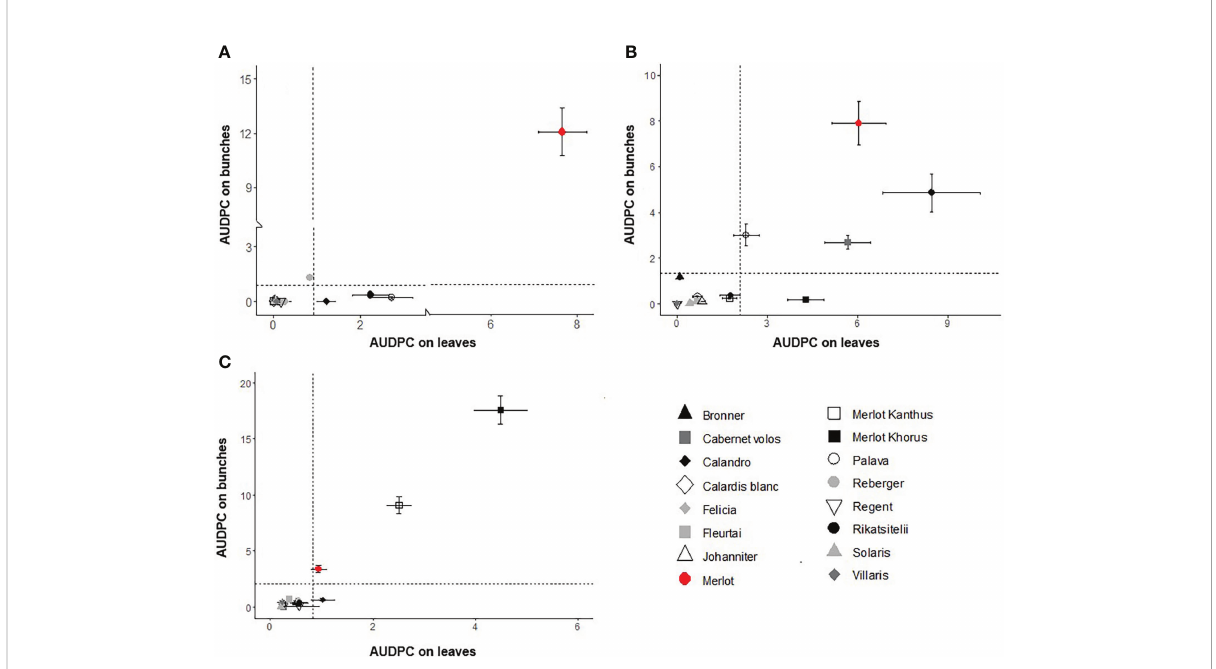
FIGURE 3 Scatter plots of AUDPC on leaves and bunches for downy mildew (A) , powdery mildew (B) , and black-rot (C) for the grape varieties listed in Table 1. Dots represent the average of a 4-year period; whiskers represent the standard error. Dotted lines dividing the graph into four quadrants indicate the 4-year average of the AUDPC values calculated for all varieties on leaves and bunches. The upper right quadrant includes varieties with high disease on both leaves and bunches; the lower right quadrant includes varieties with high disease on leaves and low disease on bunches; the upper left quadrant includes varieties with low disease on leaves and high disease on bunches; and the lower left quadrant includes varieties with low disease on both leaves and